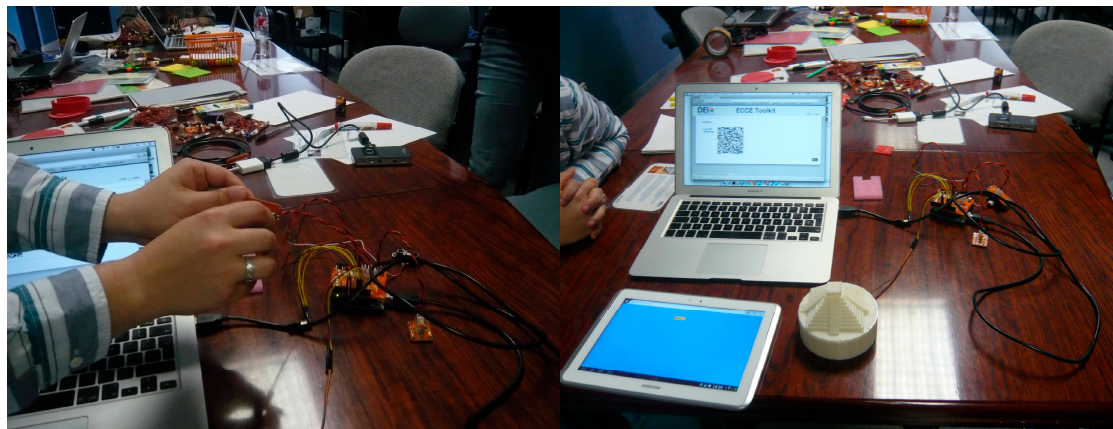
Figure 13. The implementation of a design idea with ECCE during the second workshop: ( left ) a participant connecting the sensors and, ( right ) the final implementation.